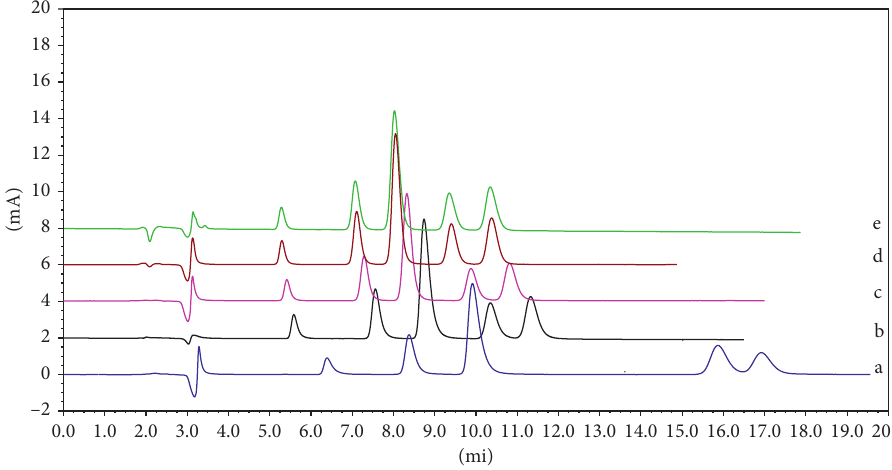
Figure 2: Typical HPLC chromatogram for simultaneous separation of ODT, GNT, TPT, AZT, and RMT. Chromatographic conditions were acetonitrile-0.05 mol · L − 1 potassium dihydrogen phosphate (25 : 75, v/v) except the buffer pH was varied: (a) pH 3.0; (b) pH 3.5; (c) pH 4.0; (d) pH 4.5; and (e) pH 5.0.